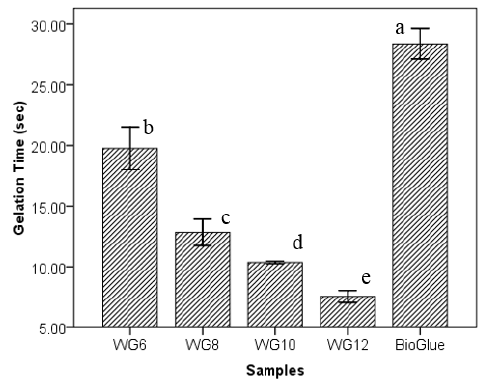
Figure 7. Gelation time of WPI/GTA adhesives and BioGlue ® (WG6, WG8, WG10, and WG12 were 40.0% of WPI solutions mixed with 6.0%, 8.0%, 10.0%, and 12.0% of GTA solutions at a ratio of 4:1 in volume) (The annotated letters indicate the statistical difference at significant level of 95.0%).